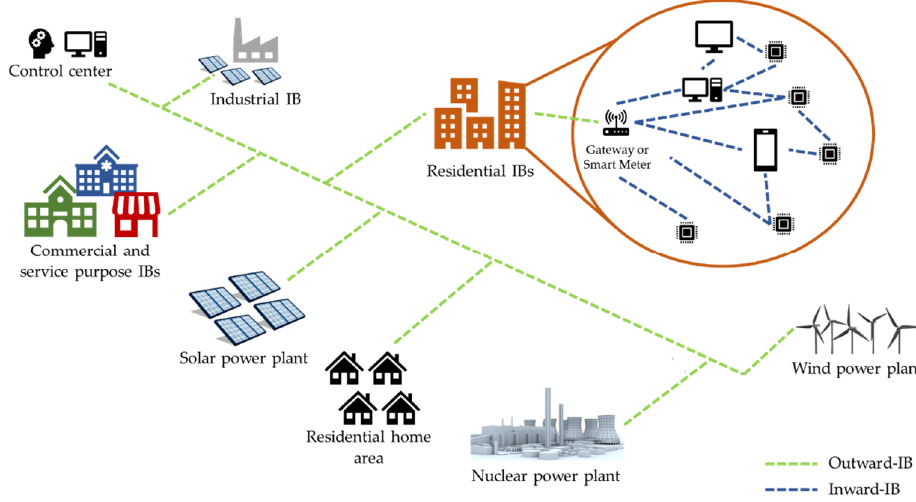
Figure 6. Inward-IB and Outward-IB communication infrastructure for the SG.